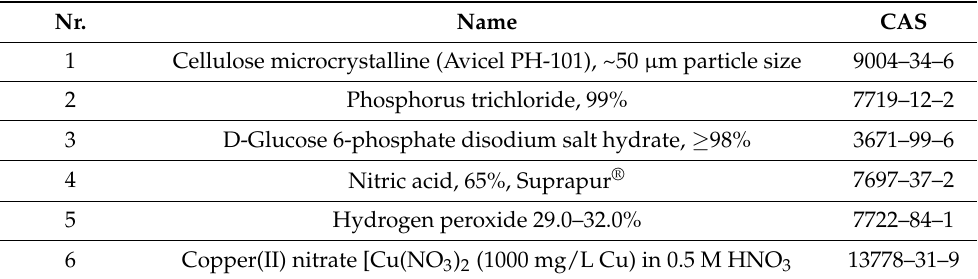
Table 13. Materials and reagents.